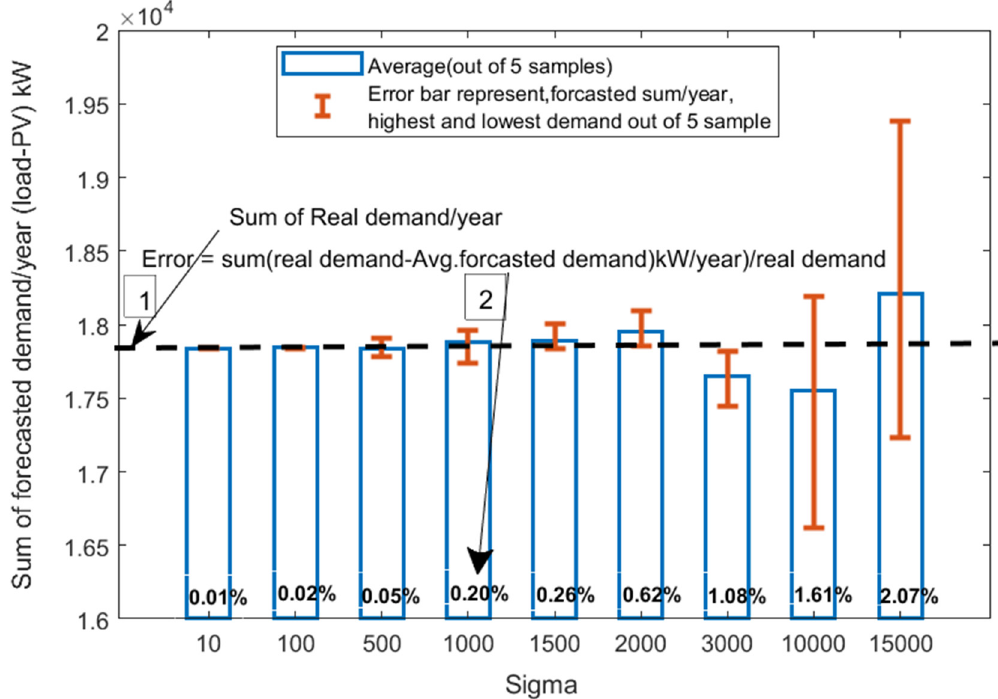
Figure 5. Average sum of the net forecasted demand per year out of five random samples. The error bars in Figure 5 above show the (cid:1840)(cid:1857)(cid:1872) (cid:3032)(cid:3045)(cid:3045)(cid:3042)(cid:3045)/(cid:3052)(cid:3032)(cid:3028)(cid:3045) for each sigma using the highest and lowest sample of (cid:1857) (cid:3033)(cid:3042)(cid:3045)(cid:3032)(cid:3030)(cid:3028)(cid:3046)(cid:3047)(cid:3046)(cid:3048)(cid:3040)/(cid:3052)(cid:3032)(cid:3028)(cid:3045) . The arrows indicating 1 and 2 in Figure 5 indicate the constant (cid:1857) (cid:3045)(cid:3032)(cid:3028)(cid:3039)(cid:3046)(cid:3048)(cid:3040)/(cid:3052)(cid:3032)(cid:3028)(cid:3045) and varying (cid:1840)(cid:1857)(cid:1872) (cid:3032)(cid:3045)(cid:3045)(cid:3042)(cid:3045)/(cid:3052)(cid:3032)(cid:3028)(cid:3045) in Equation (12), respectively. Figure 6 depicts the difference between the generated (cid:1857) (cid:3033)(cid:3042)(cid:3045)(cid:3032)(cid:3030)(cid:3028)(cid:3046)(cid:3047)(cid:3046)(cid:3048)(cid:3040)/(cid:3052)(cid:3032)(cid:3028)(cid:3045) /5 and the real power demand. The difference of the total real power demand per year with the highest and lowest sum of the generated forecasted power demand per year out of five samples at each sigma is described using the error bars on the secondary axis of Figure 6.